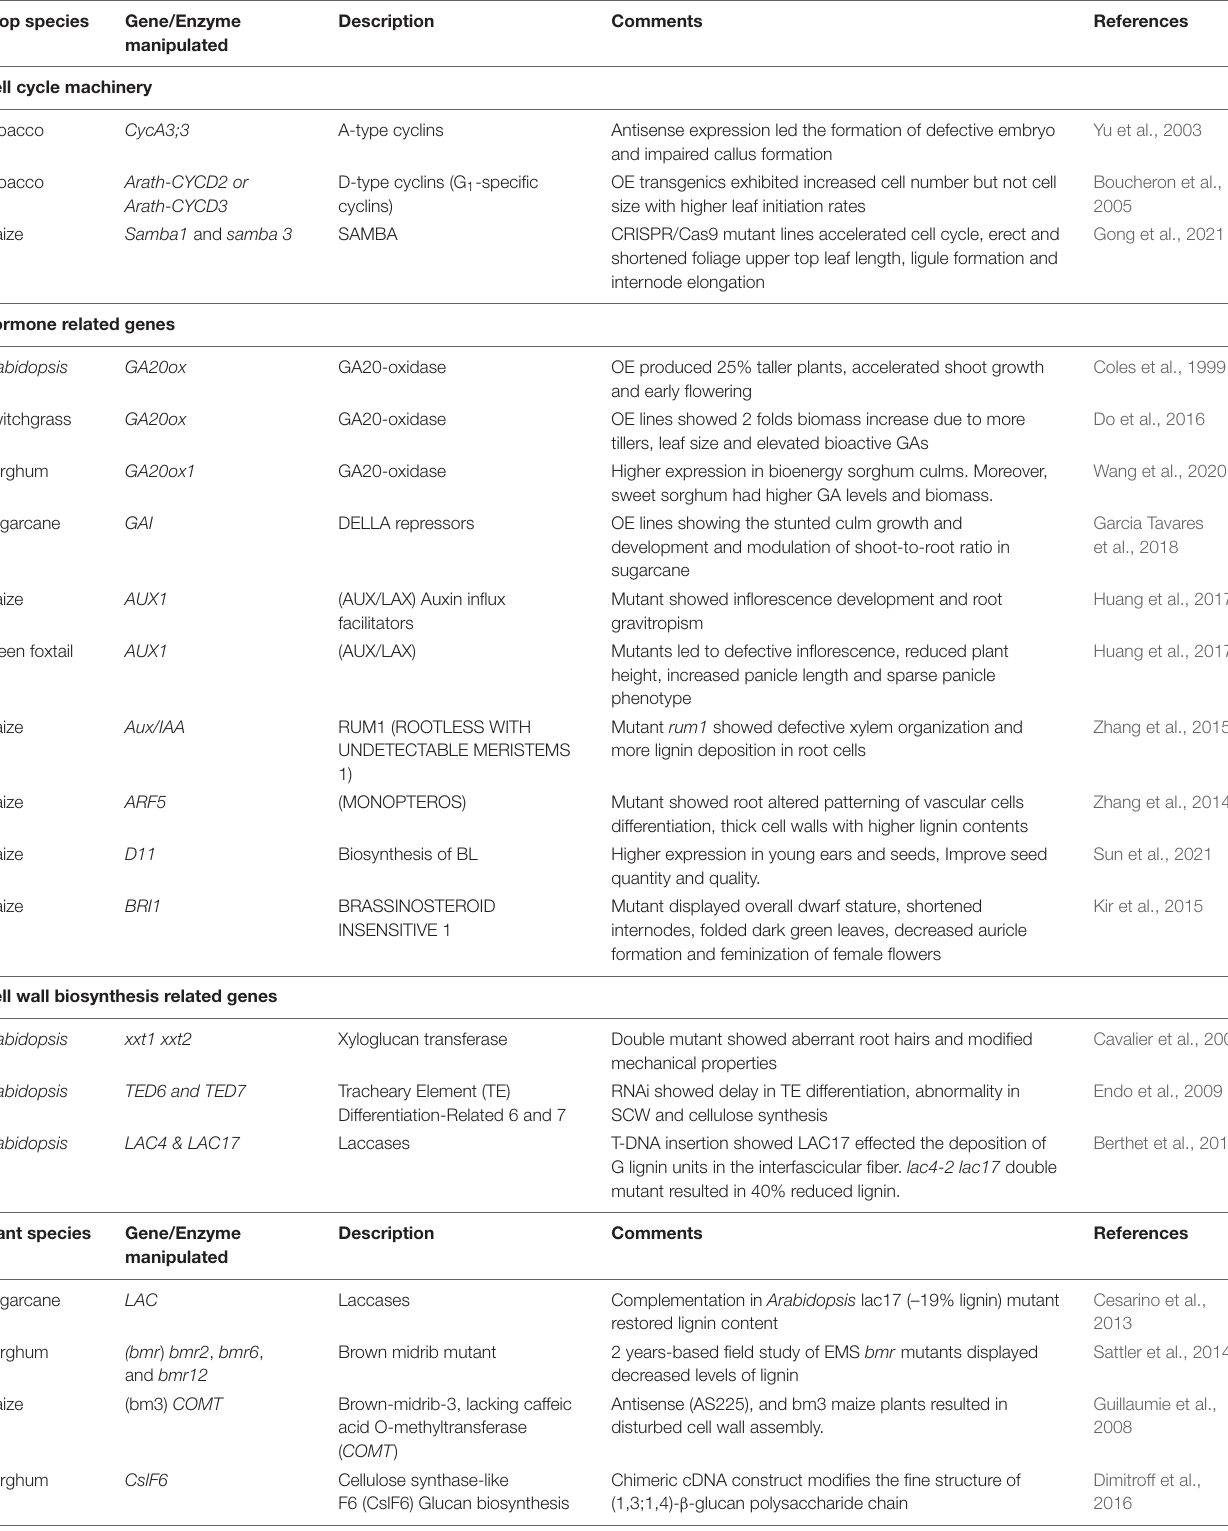
TABLE 1 | List of C 4 crops genes as candidates for exploiting biomass-related traits. Crop